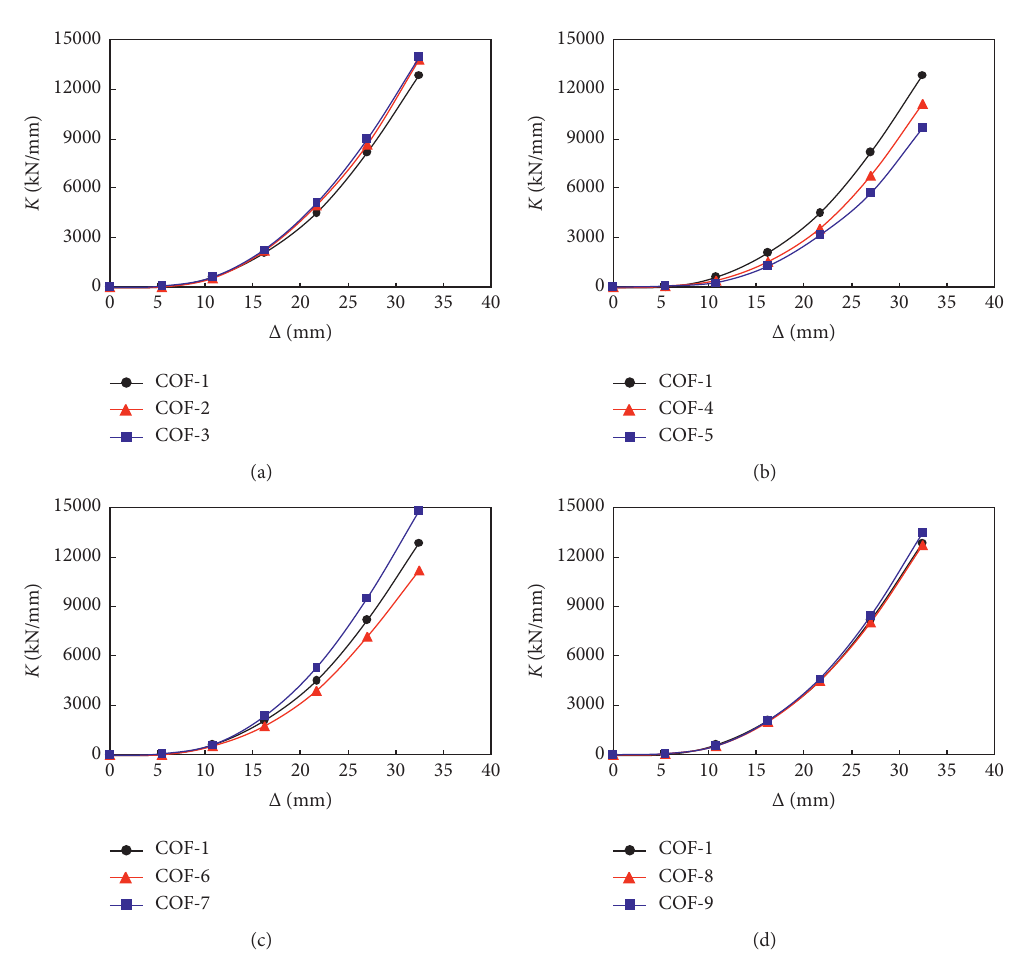
Figure 16: Comparison on energy dissipation of COF